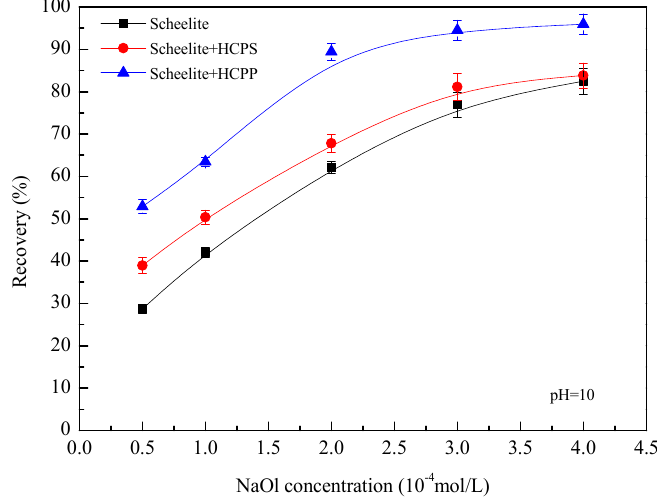
Figure 3. Flotation recovery of ultrafine scheelite with HC treatments as a function of NaOl concentration.